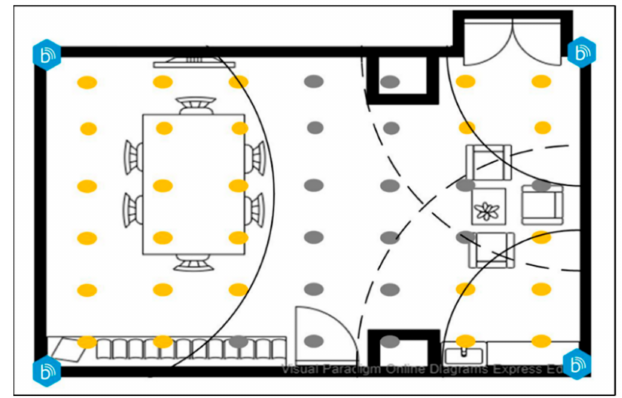
Figure 13. Active zone scope